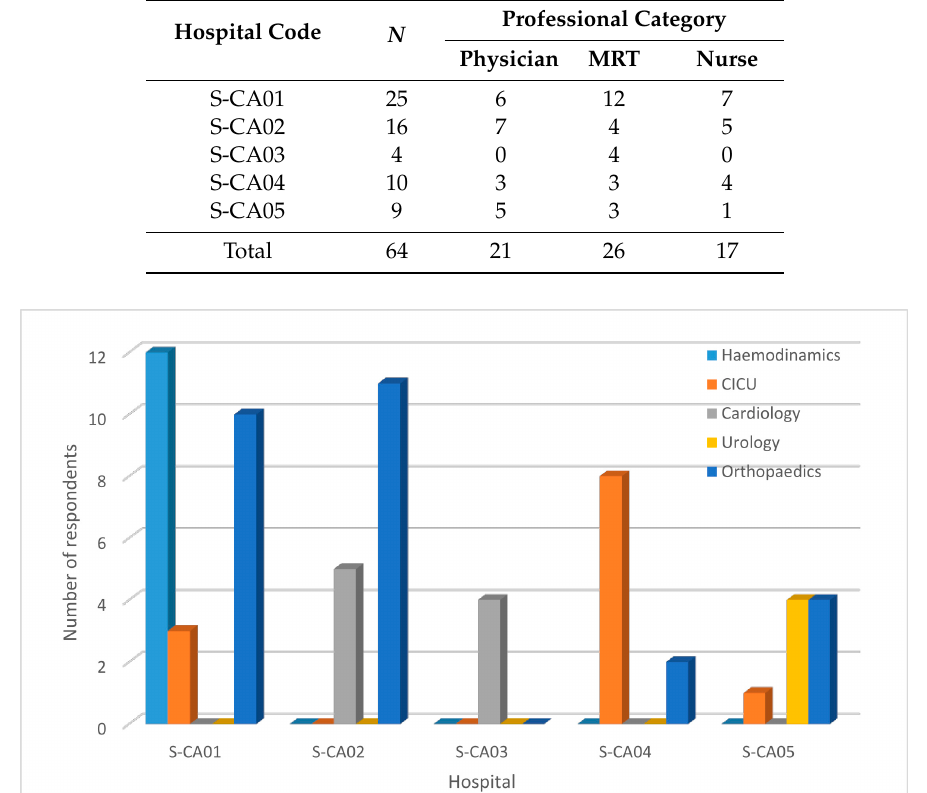
Table 3. Number (N) of respondents of the five hospitals and their corresponding distribution into the three professional categories: physician, medical radiologic technologist (MRT), and nurse.